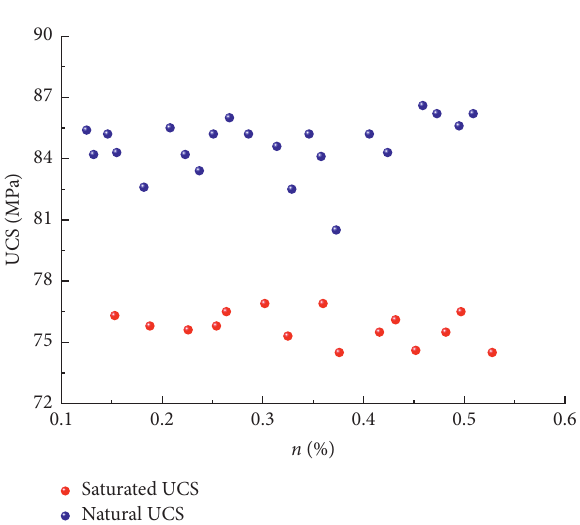
Figure 4: The fitted curves of the saturated UCS and the porosity ( n � 0.5% ∼ 5%).